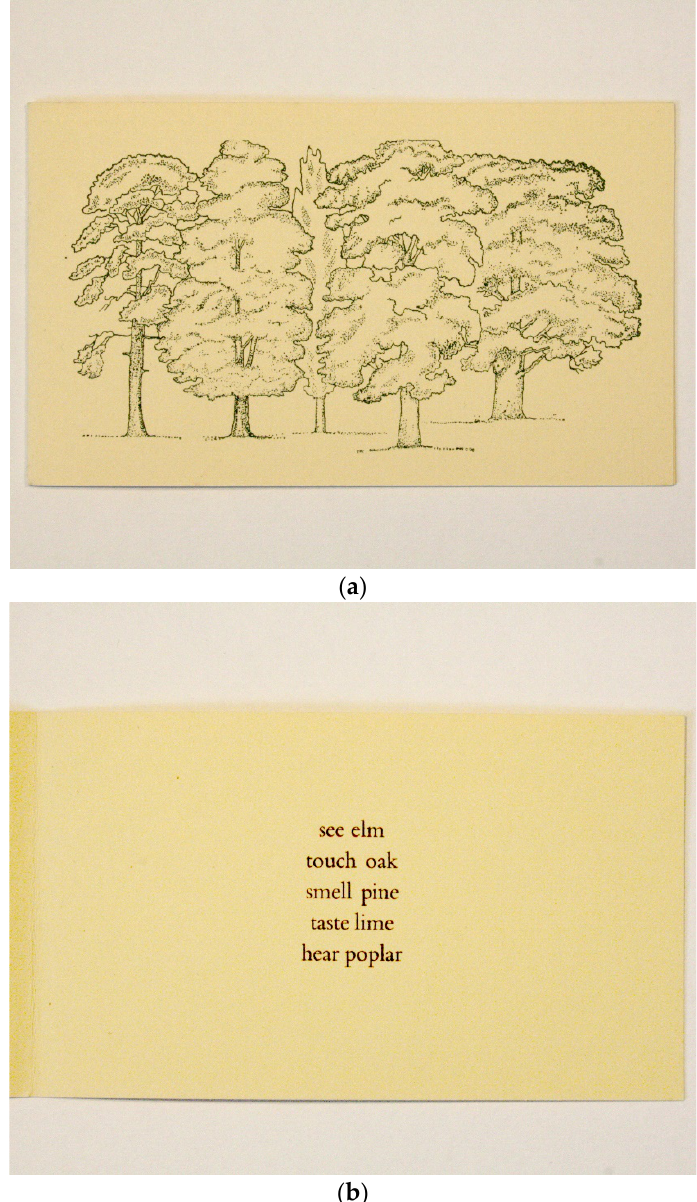
Figure 2. ( a ) Clark, T.A. and Clark, L. (1977) The Bright Glade. [folded card printed letterpress] Moschatel Press: front. Photo courtesy of Laurie Clark. ( b ) Clark, T.A. and Clark, L. (1977) The Bright Glade. [folded card printed letterpress] Moschatel Press: interior. Photo courtesy of Laurie Clark.